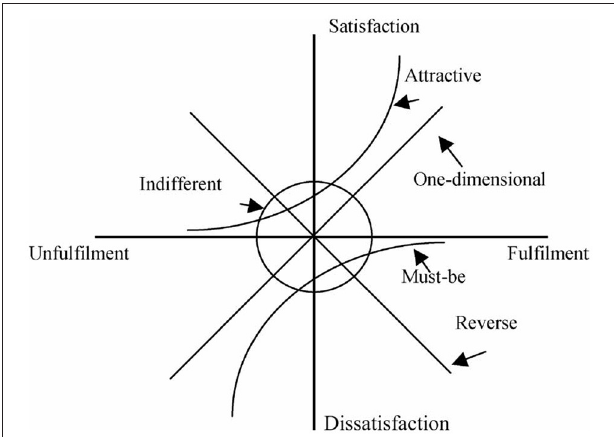
FIGURE 2 | Kano model of quality attributes (29).